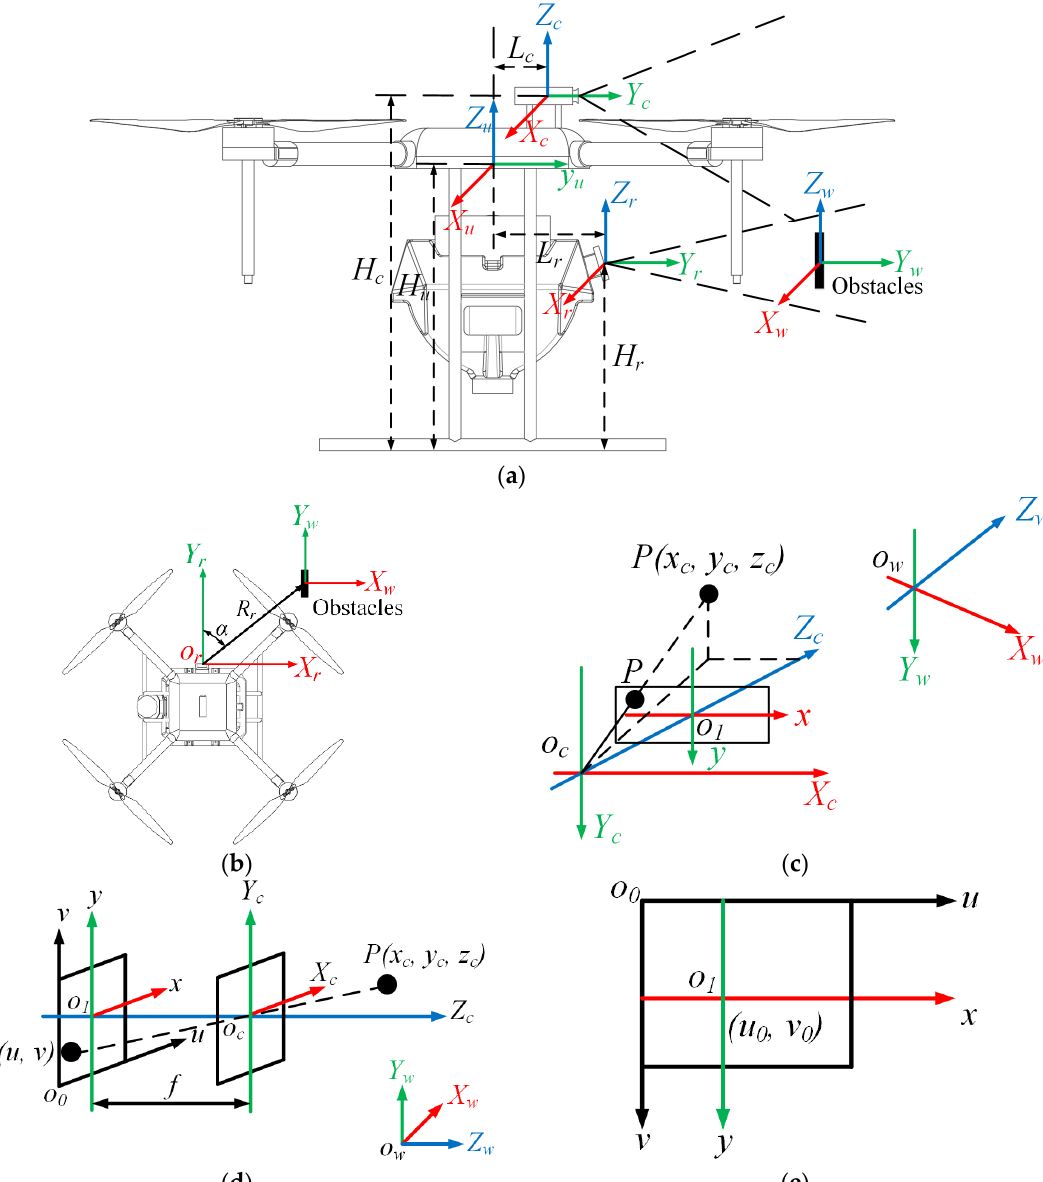
Figure 2. Spatial fusion model of MMV radar and monocular camera: ( a ) arrangement of the MMV radar and monocular camera on the UAV; ( b ) MMV radar coordinate system; ( c ) camera coordinate system; ( d ) image coordinate system; ( e ) pixel coordinate